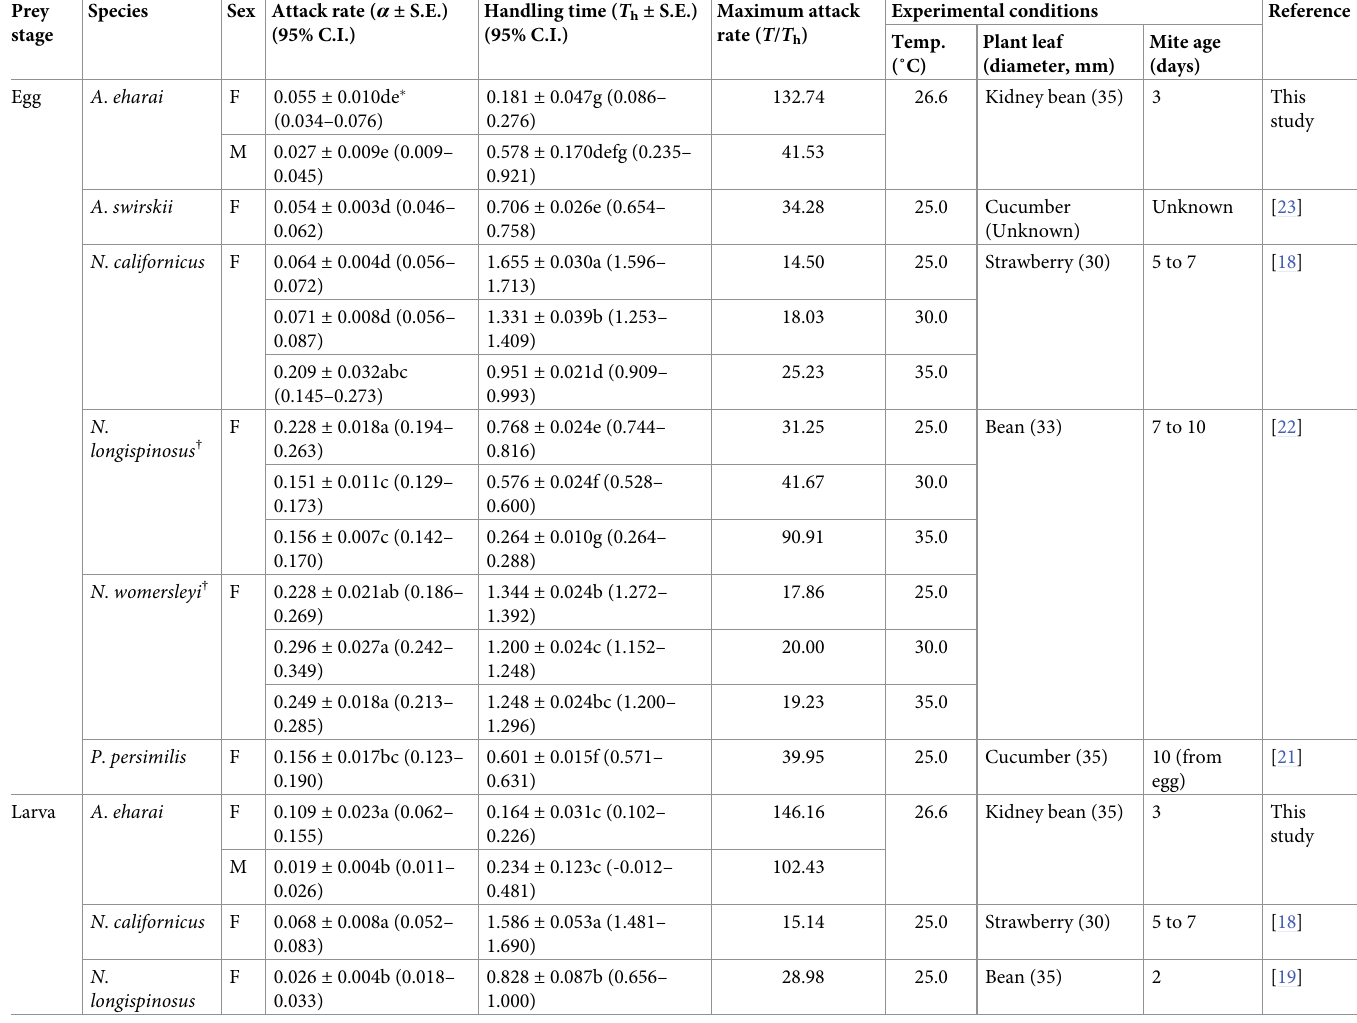
Table 6. Comparison of attack rates and handling times among the phytoseiid mites ( T = 24h). Prey Species Sex Attack rate ( α ± S.E.) stage (95%